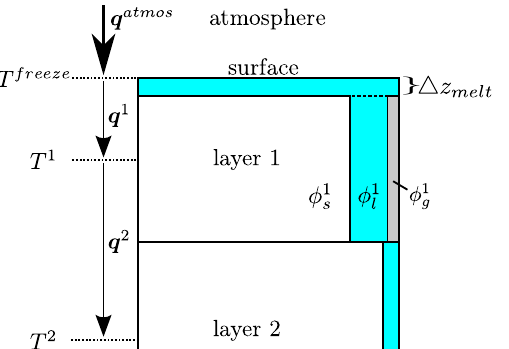
Figure 3. Sketch of meltwater formation caused by surface melting as described in Sect. 2.3.2. The white, blue, and grey areas repre- sent the solid, liquid, and gas volume fractions of each model layer ( φ s , φ l , and φ g ). The meltwater is located in a film which is (cid:52) z melt thick and located below the surface of the top layer. (cid:52) z melt is deter- mined by the amount of latent heat release necessary to balance the energy difference between the atmospheric heat flux to the surface q atmos and the flux from the surface into the top ice layer q 1 .